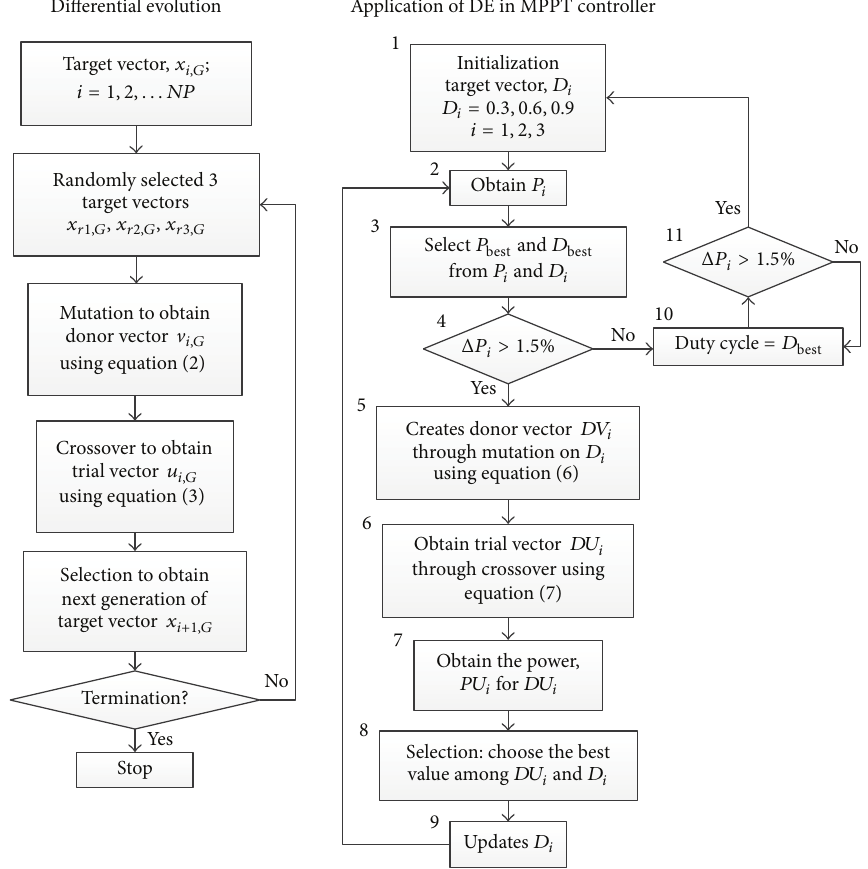
Figure 3: Flow chart of differential evolution algorithm and proposed algorithm.